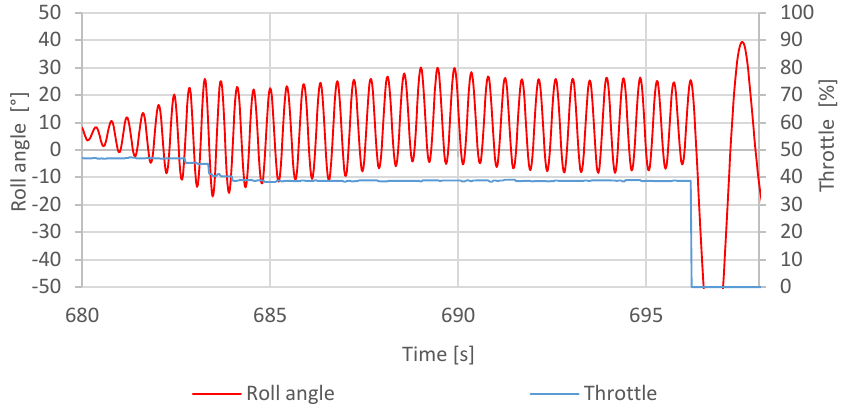
Figure 12. Data gathered during the Z – N (Ziegler – Nichols) tuning procedure — 𝐾 𝑢 = 1.1 . [5].